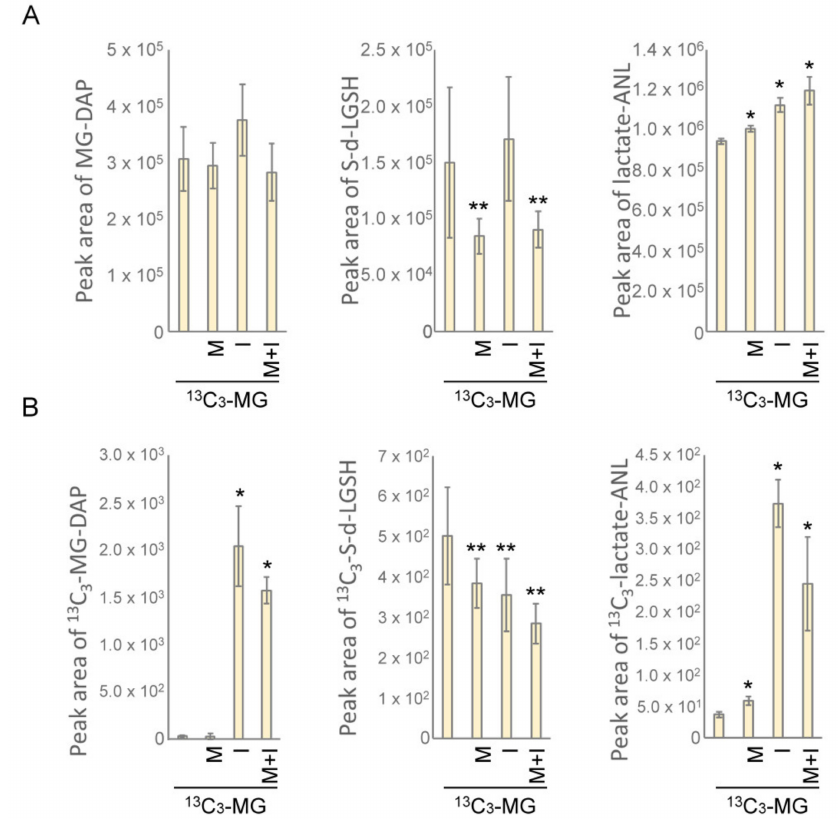
Figure 6. The change of intracellular MG, S-d-lactoylglutathione, and lactic acid in insulin- and metformin-treated HEK293T cells. The levels of ( A ) MG (MG-DAP), S-d-lactoylglutathione, and lactic acid (lactate-ANL) from glucose catabolism and ( B ) 13 C 13 C 13 C 13 C 3 -MG-DAP, 3 -S-d-lactoylglutathione, and 3 -lactate-ANL from added 3 -MG were determined by LC-ESI-MS by applying 80 µ M 13 C 3 -MG ( 13 C 3 -MG) in medium for tracking with 4 h incubation. M: 10 mM metformin; I: 10 ng/mL insulin; M+I: 10 mM metformin + 10 ng/mL insulin. Results significantly different from control at p < 0.05 are indicated by * ( n = 3) and ** ( n = 9).